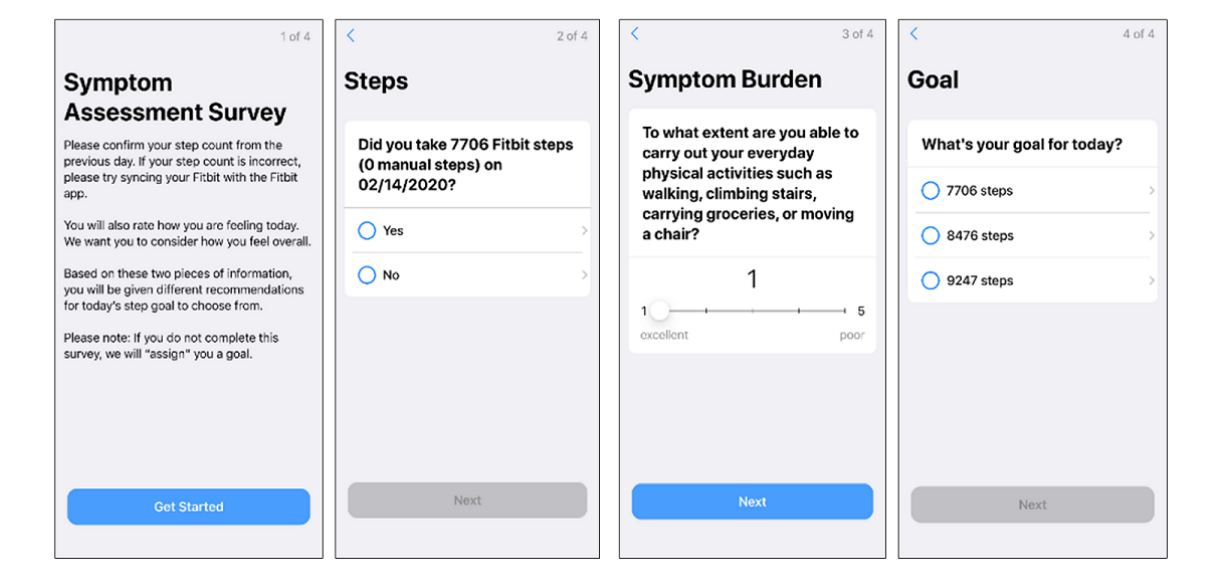
Figure 4. Fit2ThriveMB app symptom burden and goal-setting